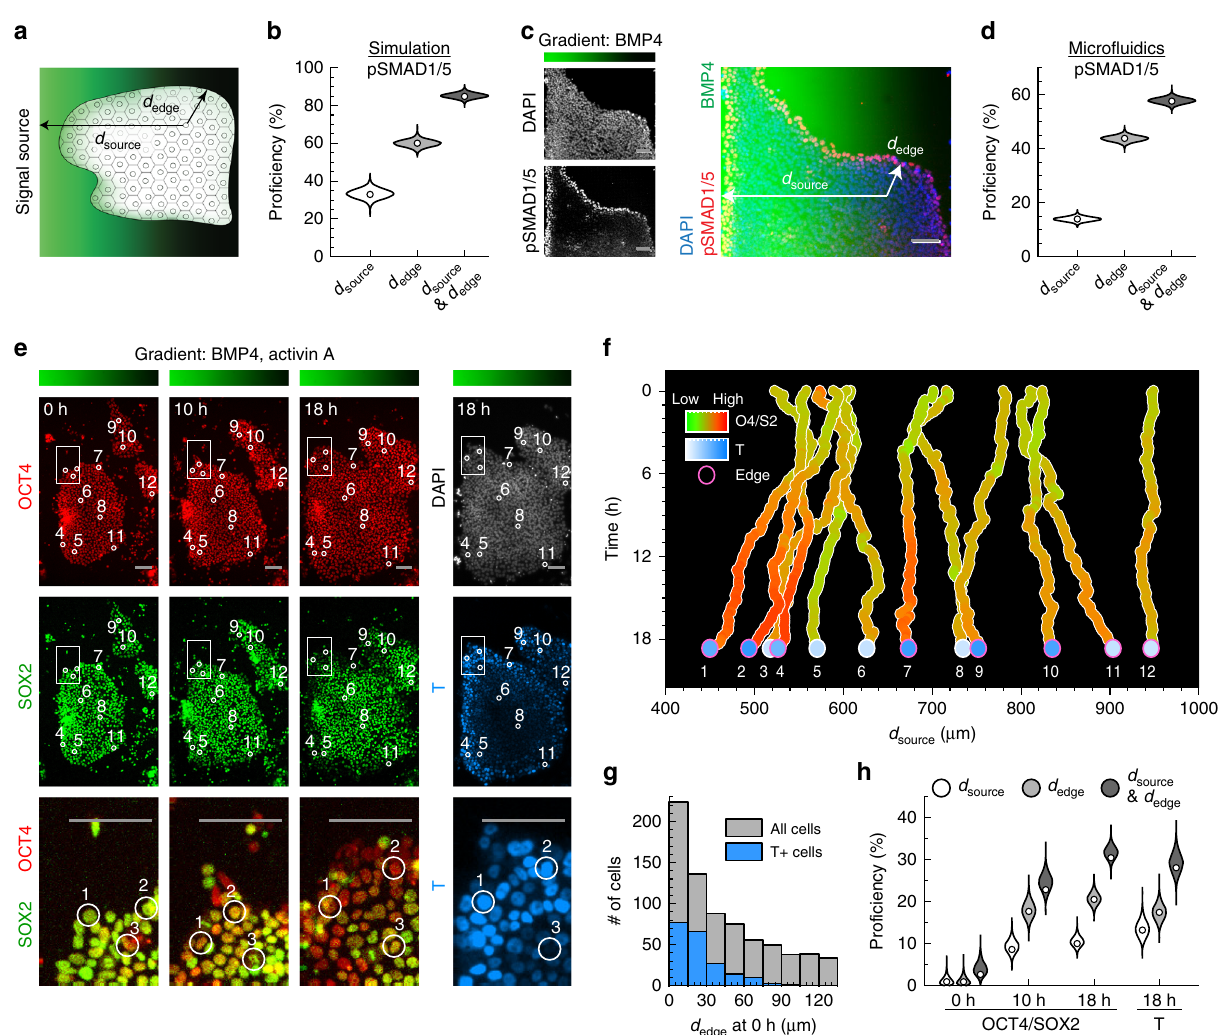
Fig. 7 Distance from tissue edge and distance from signal source govern patterning of epithelial tissue. a Illustration of epithelial tissue within a morphogen gradient emanating from a source to the left. The coordinates d edge and d source denote a cell ’ s distance from the nearest tissue edge and from the signal source, respectively. b Pro fi ciency of d source , d edge , or both coordinates to predict pSMAD1/5 level of epiblast cells in simulation (Fig. 1). c Epithelial hESC colony exposed to BMP4 gradient in micro fl uidic device for 30 min and stained for DNA and pSMAD1/5. BMP4 gradient ranges from 10 ng/mL (green) to 0 ng/mL (black). Coordinates d source and d edge are depicted for a single cell as in a . These images are representative of fi ve sets of images from two experiments. d Pro fi ciency of d source , d edge , or both coordinates to predict pSMAD1/5 levels in hESCs exposed to micro fl uidic BMP4 gradient ( n = 13,828 cells). e OCT4-RFP (red) SOX2-YFP (green) double reporter hESCs within micro fl uidic gradient after 0, 10, and 18 h of differentiation. DNA, white; BRACHYURY/T, teal. Inset highlights differentiation at colony edges. Position of 12 sample cells labeled by circles. Bar above shows BMP4 and ACTIVIN A gradient within micro fl uidic device, ranging from 10 ng/mL (green) to 0 ng/mL (black) of each. These images are representative of two sets of images from two experiments. f d source of 12 tracked cells from e throughout time-lapse, colored by OCT4/SOX2 ratios (red/green) and BRACHYURY/T level (teal) at end of time-lapse. Pink circles mark cells with d edge less than 52 µ m at 10 h of differentiation. g Distribution of d edge at start of differentiation, with teal marking cells that were BRACHYURY/T + after 18 h of differentiation. h Pro fi ciencies of d source , d edge , or both coordinates to predict OCT4/SOX2 ratios and BRACHYURY/T levels ( n = 1275 cells). Violin plots denote Gaussian kernel density estimates. Scale bar 100 µ